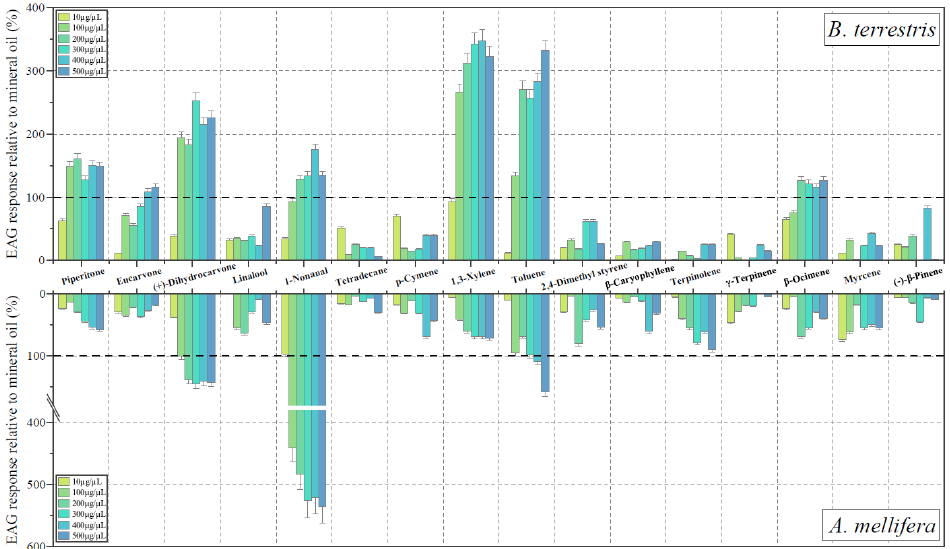
Figure 1. Normalized EAG responses of bees to volatile compounds. ( top ) Normalized EAG response relative to mineral oil of B. terrestris ; ( bottom ) normalized EAG response relative to mineral oil of A. mellifera . The bolded black dotted line represents the response of the control mineral oil (100%). Antennal sensitivity to the different compounds was not consistent across